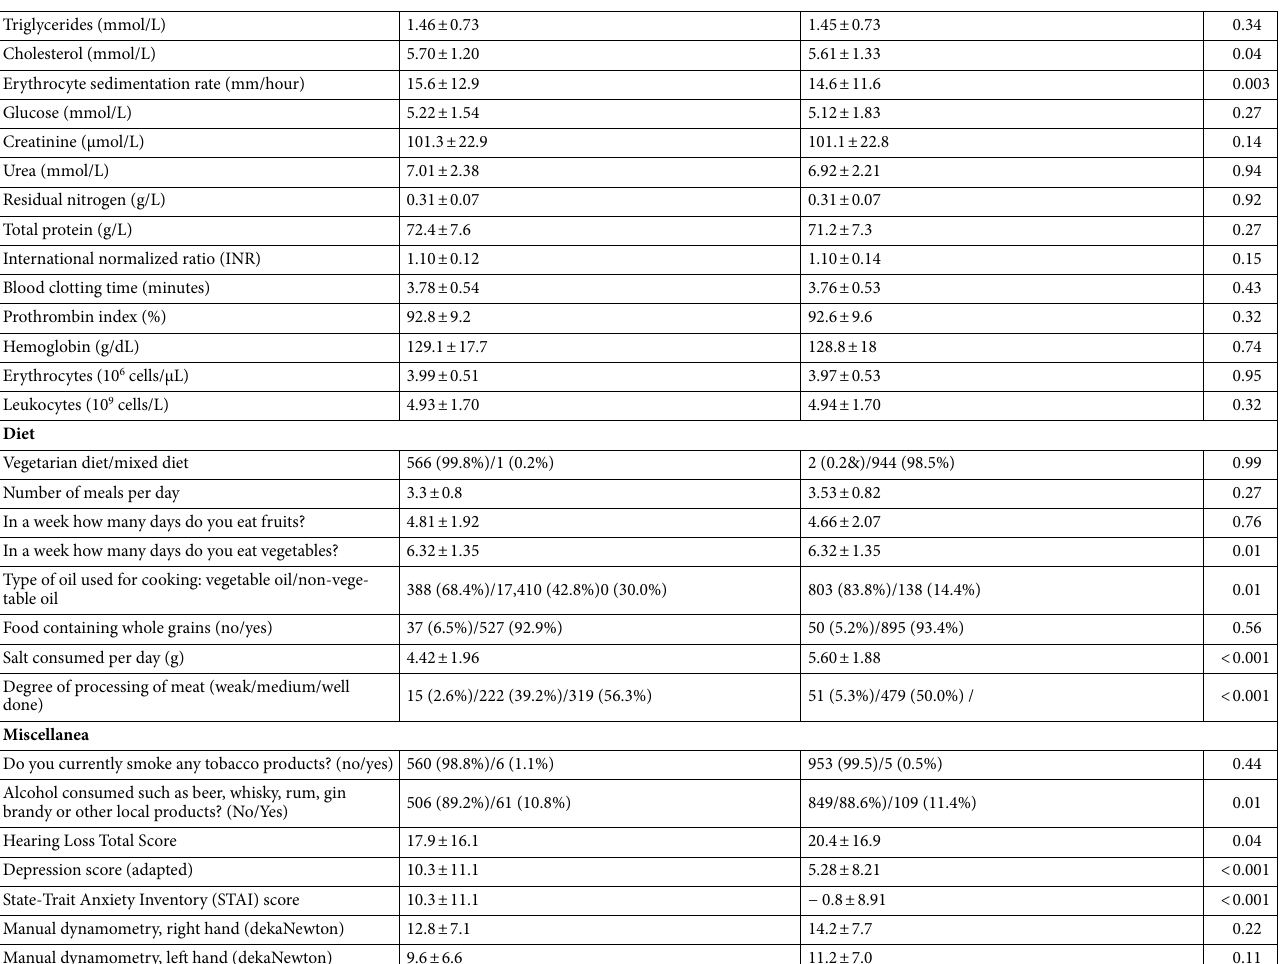
Table 4. Demographic parameters of the population of the Ural Very Old Study, stratified by the presence of osteoarthritis.